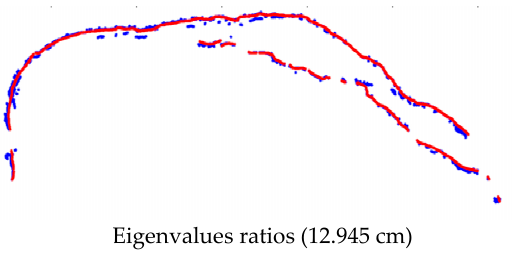
Figure 17. The discrepancies between the ground truth (red) and the extracted landslide scarp data collected using the data collected in May 2015 (blue). Table 4. Comparison of the statistical quality assessment results for landslide scarp segments extracted from the Kings Park, Lethbridge landslide study area from both datasets, May 2014 and May 2015.